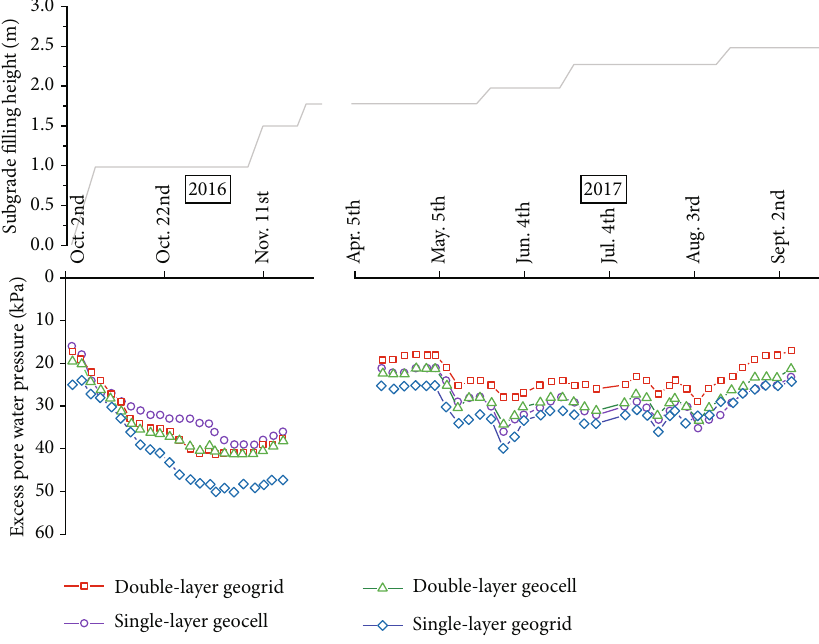
Figure 8: Pore water pressure-time variation